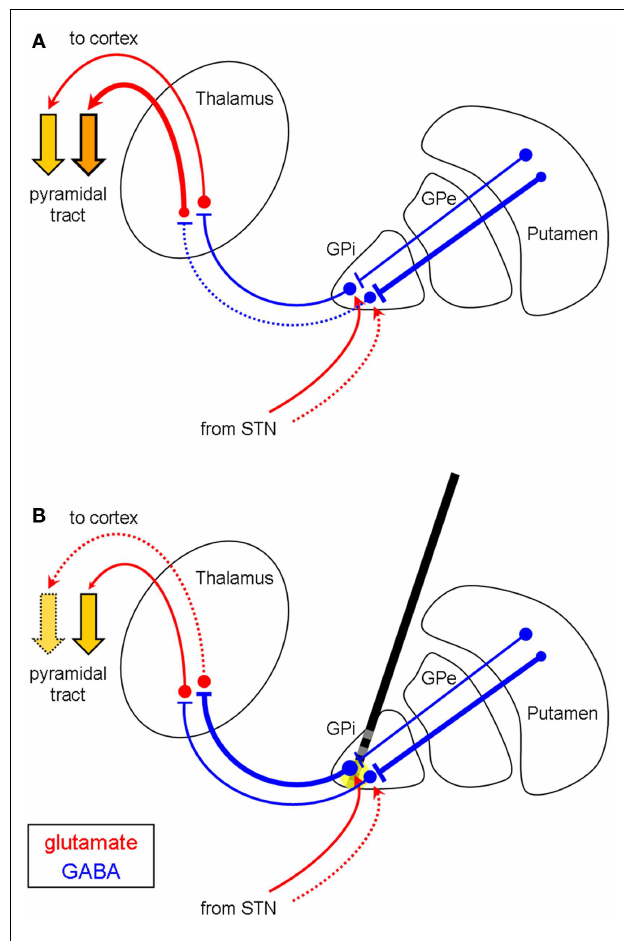
FIGURE 2 | Differential efficacy of pallidal HFS depending on the somatotopic distribution in focal/segmental dystonia (coronar view) . (A) Disinhibition of the thalamus in the upper extremity (neurons in the ventro-lateral part of the GPi), but not in the lower limbs (medio-dorsal GPi), resulting in dystonia of the arms but not the legs. HFS of the medial GPi [ (B) , yellow circle] increases the GABAergic outflow of the pallido-fugal fibers to the thalamus, which results in reduced hyperkinesia of the arms, but in hypokinesia (e.g., FOG) of the legs. Abbreviations and symbols are as in Figure 1 . Pyramidal tract: dotted arrow = hypokinetic